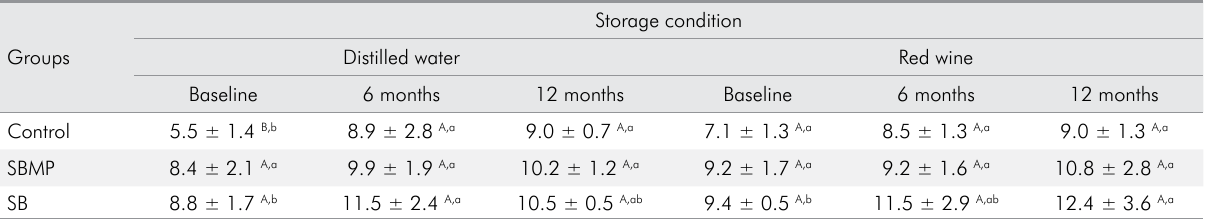
Table 1. Translucency parameter means and standard deviations (±SD) of groups after different periods of water or wine storage. Groups